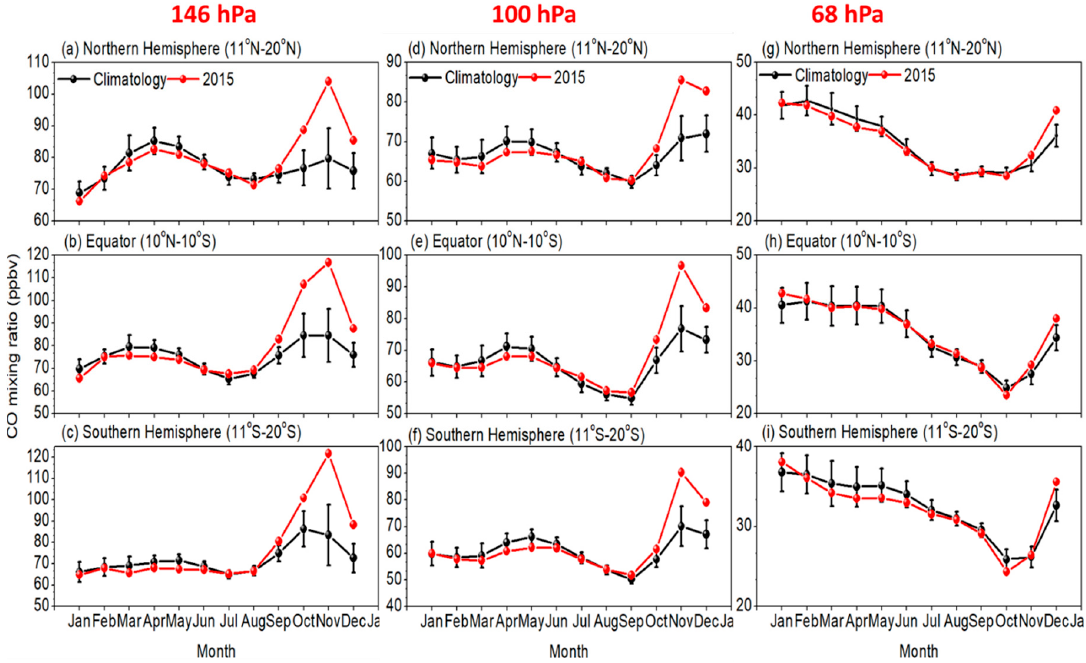
Figure 3. Same as Figure 2 but for the monthly mean of carbon monoxide at 146 hPa 100 hPa and 68 hPa. To quantify the changes in the trace gases during the year 2015, we have estimated the monthly anomalies by subtracting the climatology from the individual monthly mean trace gas concentrations.